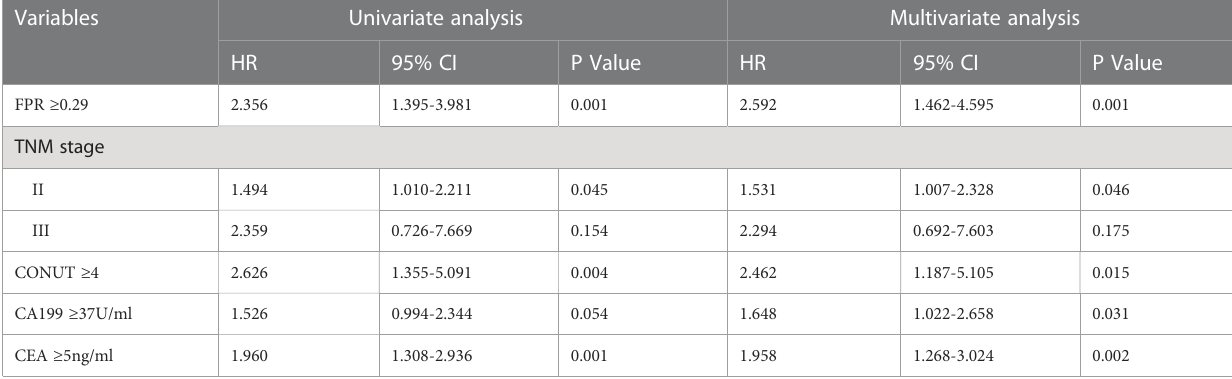
TABLE 3 Univariate and multivariate analysis of risk factors for overall survival in training cohort. Variables Univariate analysis